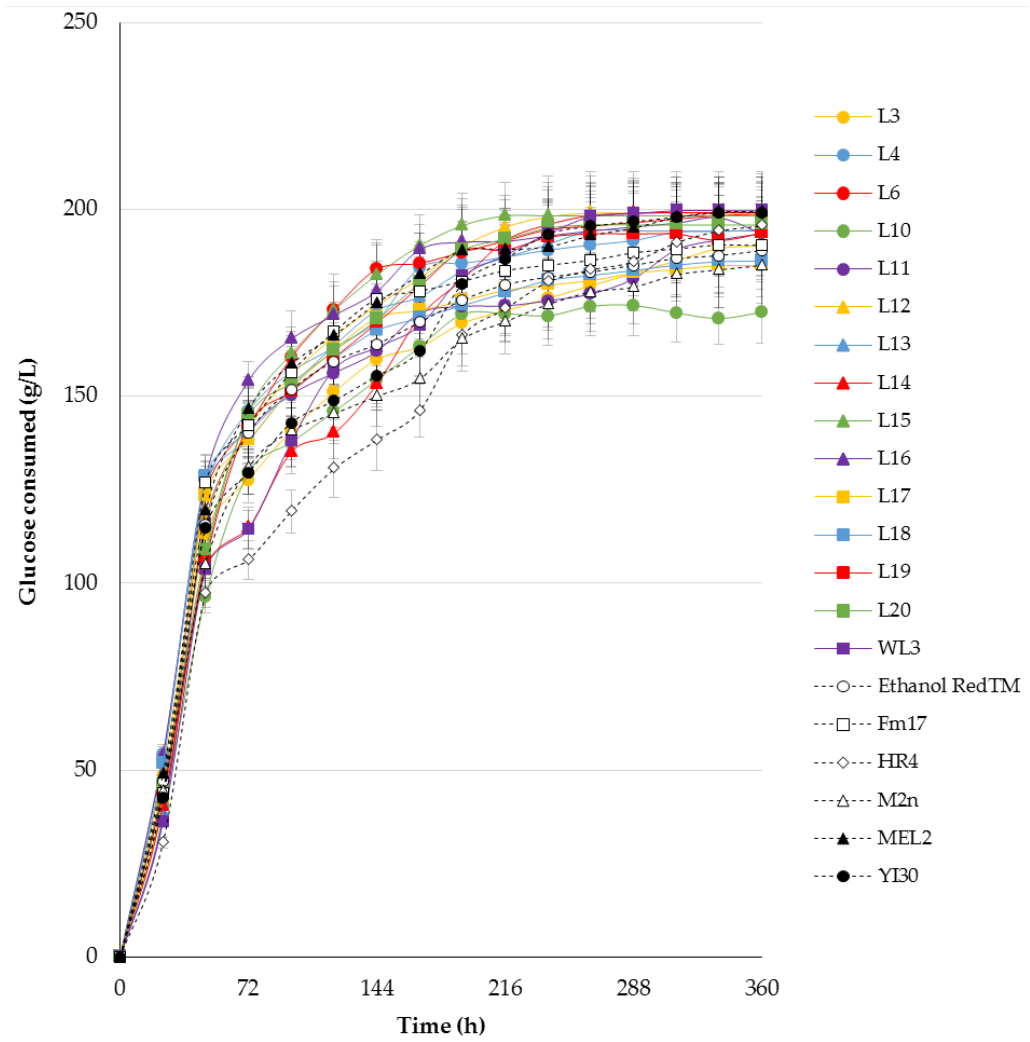
Figure 1. Cumulative sugar utilization (g/L) of S. cerevisiae strains in MNS medium with 200 g/L glucose. The experiment was conducted in triplicate (±SD).